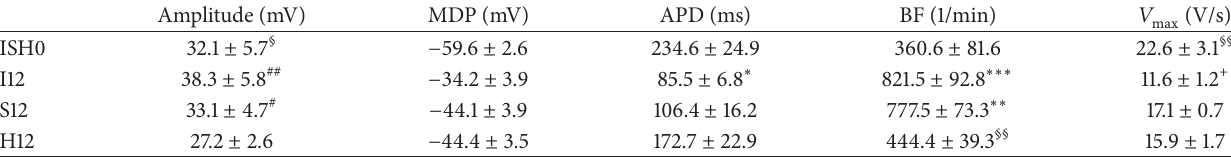
Table 1: Action potential parameters of cell populations from different cell culture